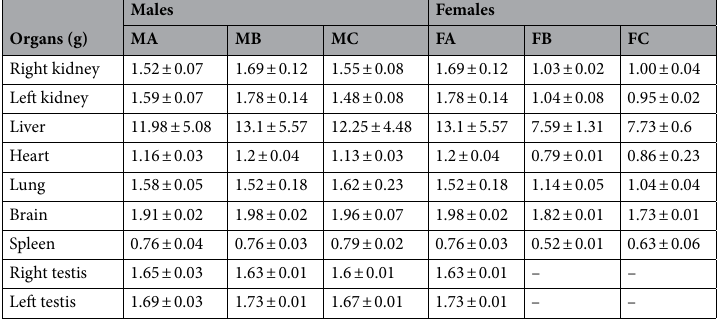
Table 6. Organ weights of rats in the studied groups on the 90th day. MA: male rats with Tarom molaii rice feeding, MB: male rats with GM Bt rice feeding, MC: male rats with standard feeding, FA: female rats with Tarom molaii rice feeding, FB: female rats with GM Bt rice feeding, FC: female rats with standard feeding.